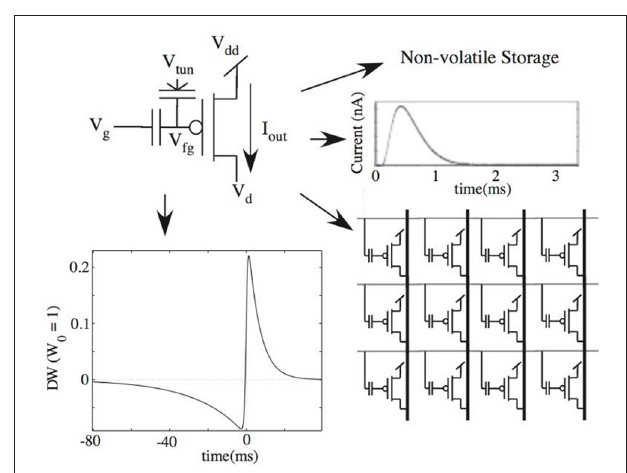
FIGURE 25 | A single transistor synapse device is presented;the architecture uses non-volatile storage, generates biological post-synaptic potential (PSP) outputs, can easily be arrayed in a mesh architecture, and demonstrates biological synapse learning rules such as long-term potentiation (LTP), long-term depression (LTD), and spike time dependent plasticity